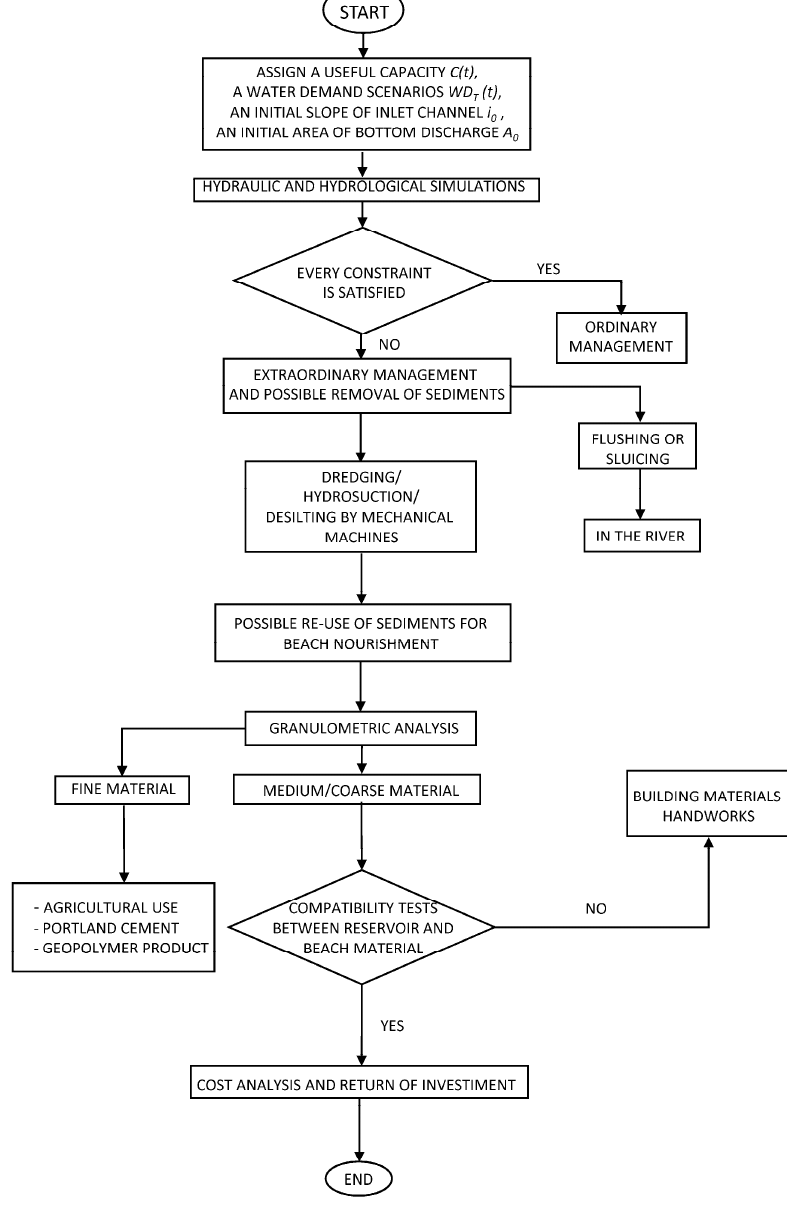
Figure 1. Flow chart of proposed methodology.